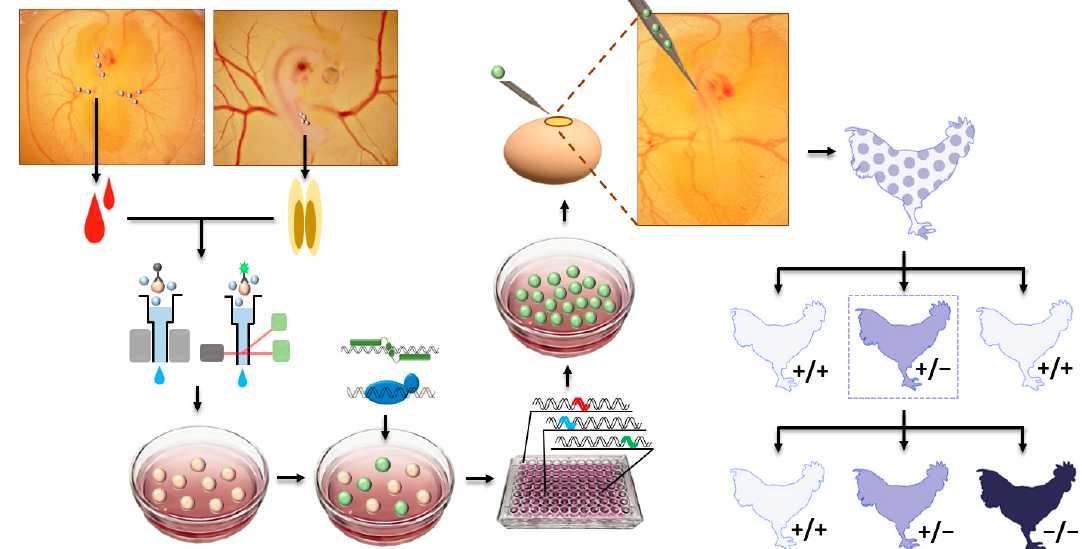
Figure 2. Graphical summary of primordial germ cell (PGC)-mediated method for genome editing in the chicken. Chicken PGCs are isolated from embryonic blood or gonad by magnetic activated cell or fluorescence-activated cells sorting, using PGC-specific antibodies. After culture of chicken PGCs, genome-editing tools, transcription activator-like e ff ector nucleases or clustered regularly interspaced short palindromic repeats (CRISPR) / Cas9, are applied to cells which are screened by antibiotic selection or fluorescence-activated cell sorting. Then, single cells are proliferated and sequenced to detect genome-edited cells for injection into the dorsal aorta of recipient chicken embryos. After generation of potential germ-line chimeric chicken, the chimeras are mated with wild-type partners to produce wild-type ( +/+ ) and heterozygous mutant ( +/ − ) chickens. The +/ − o ff spring are mated with another +/ − o ff spring to generated +/+ , +/ − , and homozygous mutant ( − / − )